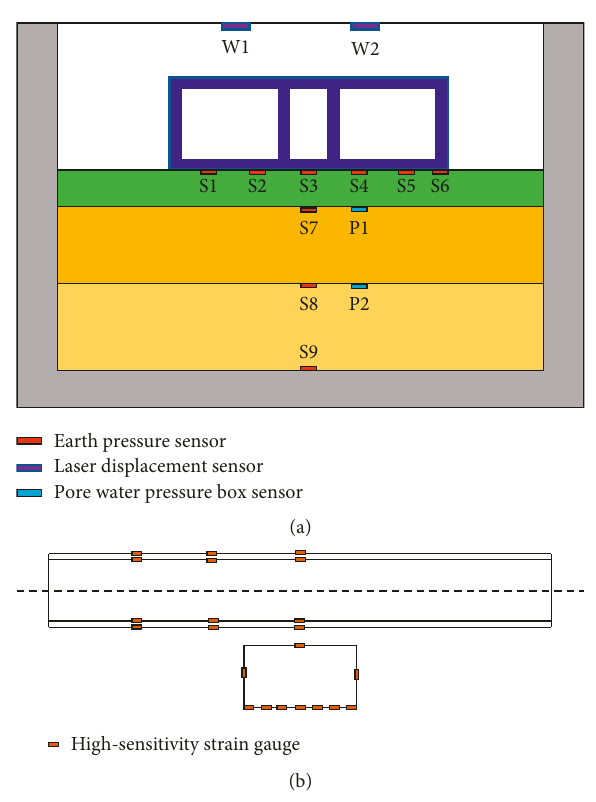
Figure 4: Test section and sensor arrangement: (a) layout of the pressure sensor; (b) layout of strain gauges.